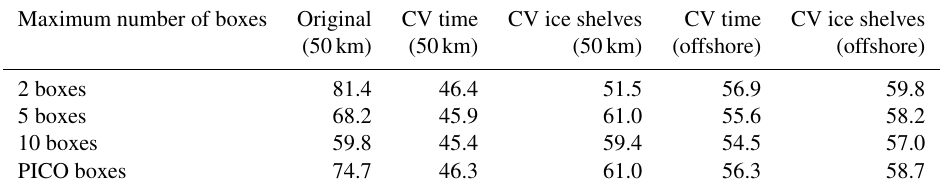
Table 7. Root-mean-squared error (RMSE int ) between the reference (NEMO) and parameterised (box parameterisation) yearly integrated ice-shelf melt [Gtyr − 1 ] over the 35 individual ice shelves and 127 simulation years using the original parameters (Reese et al., 2018a). RMSE int over the synthetically independent evaluation dataset resulting from the cross-validation (CV) over time and the cross-validation over ice shelves. RMSE is given for the version with heterogeneous boxes, and for the use of input from the 50km and the offshore domains.